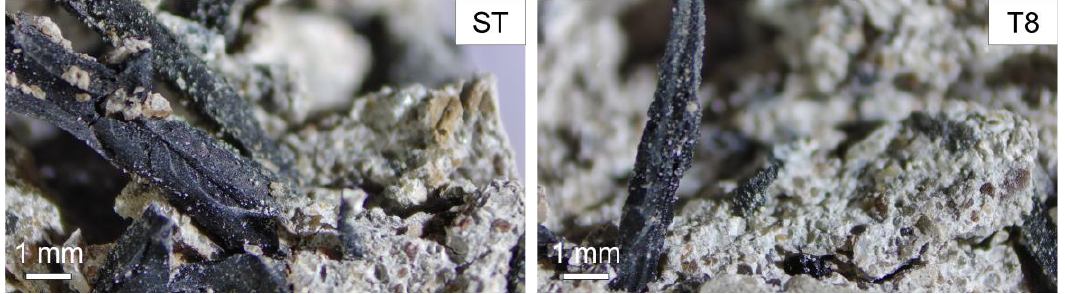
Figure 9. Microscopy images of samples ST and T8 and details of the shreds and fibres,